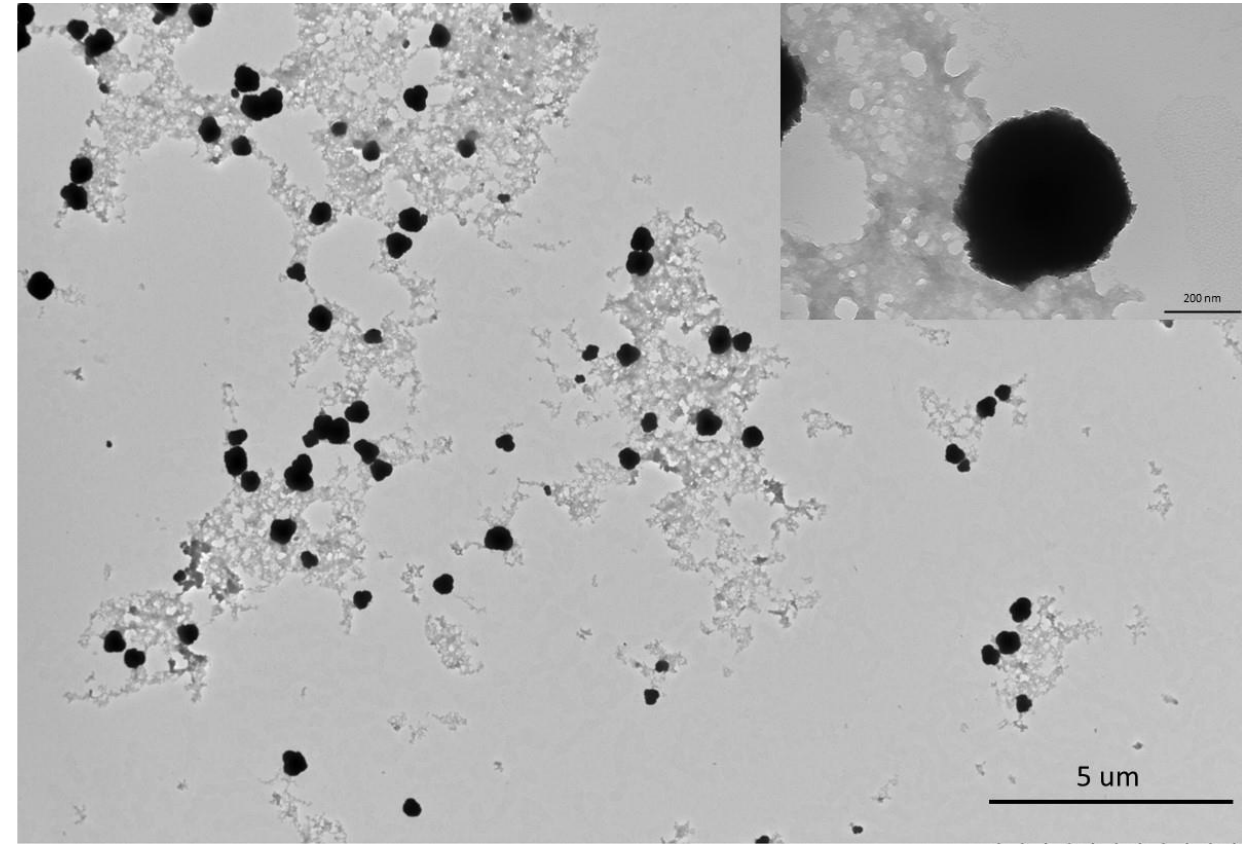
Figure 3. A transmission electron microscopy (TEM) image of C. siliqua bio-ZnONPs.